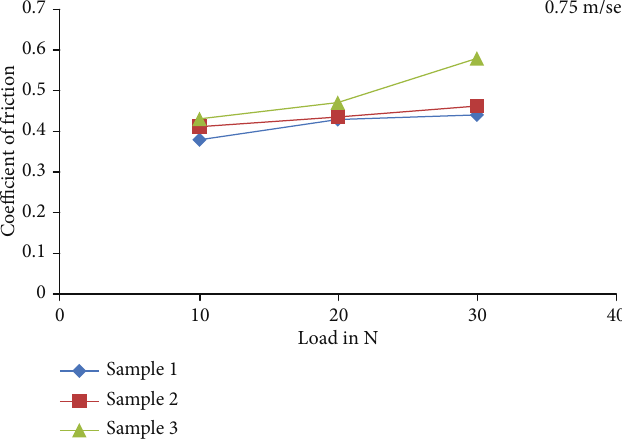
Figure 6: Coe ffi cient of friction (COF) of silver hybrid nanocomposite.